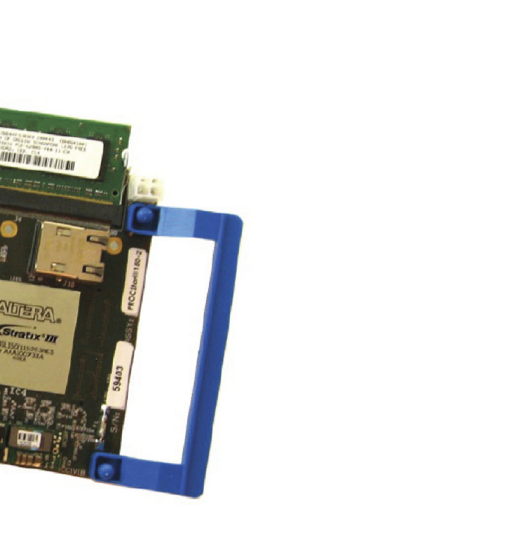
PLOS ONE | DOI:10.1371/journal.pone.0124176 May 8,